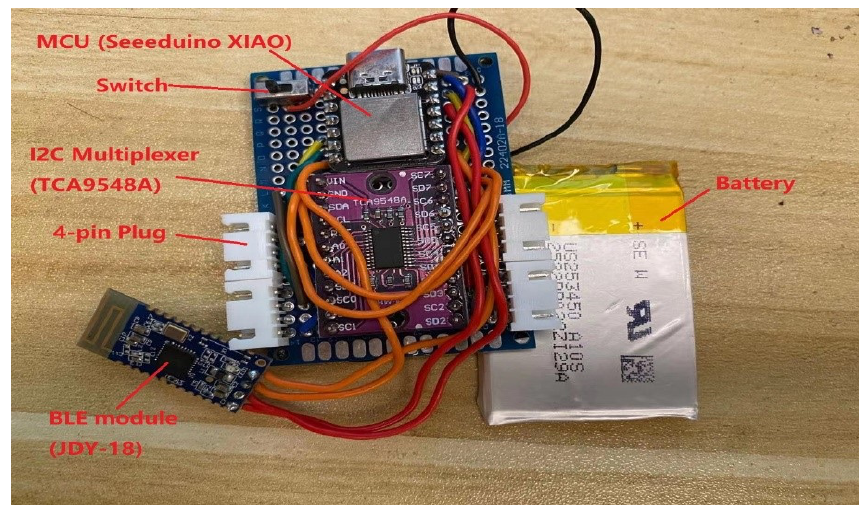
Figure 4. Processing unit that consists of an MCU, an I2C multiplexer, a BLE 4.2 module, and a lithium-ion battery.